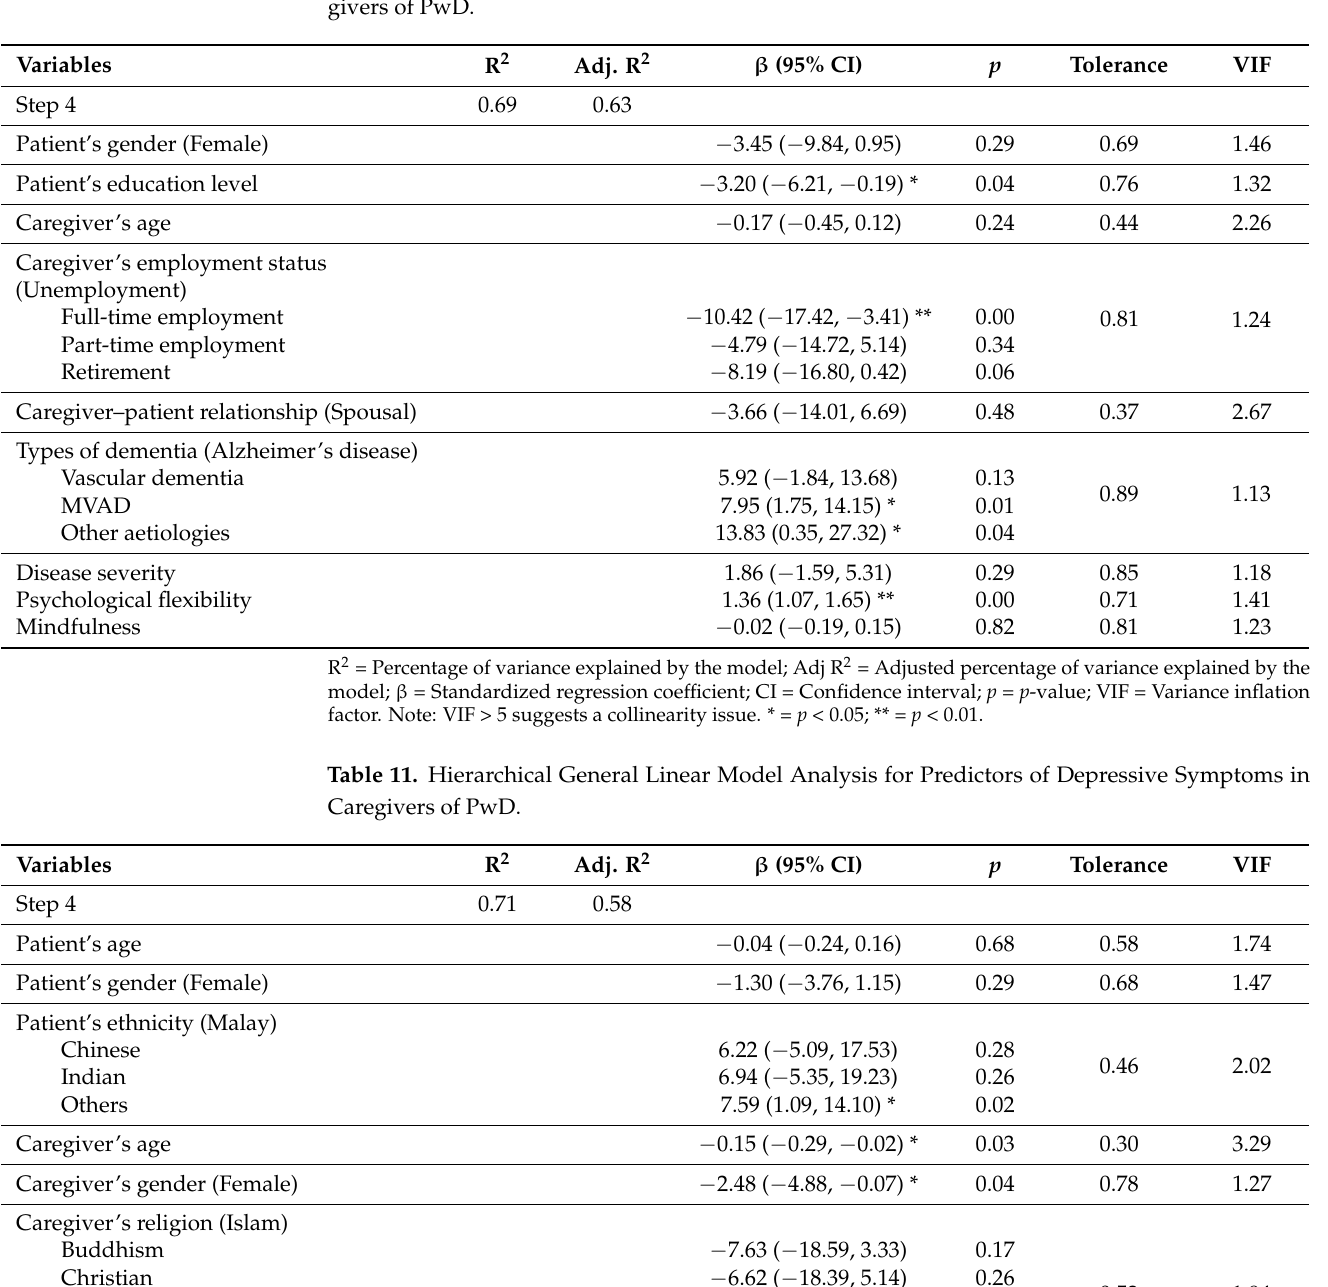
Table 10. Hierarchical General Linear Model Analysis for Predictors of Caregiver Burden in Care- givers of PwD.